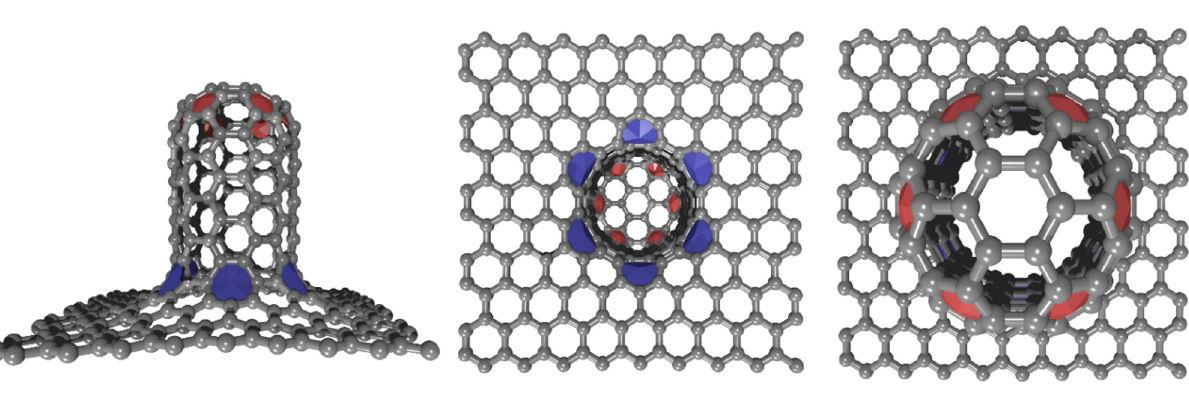
Figure 1. Atomic structure of the graphene–CNT (6,6) composite after optimization in SIESTA. Heptagons are shown in blue colors, while pentagons are shown in red.